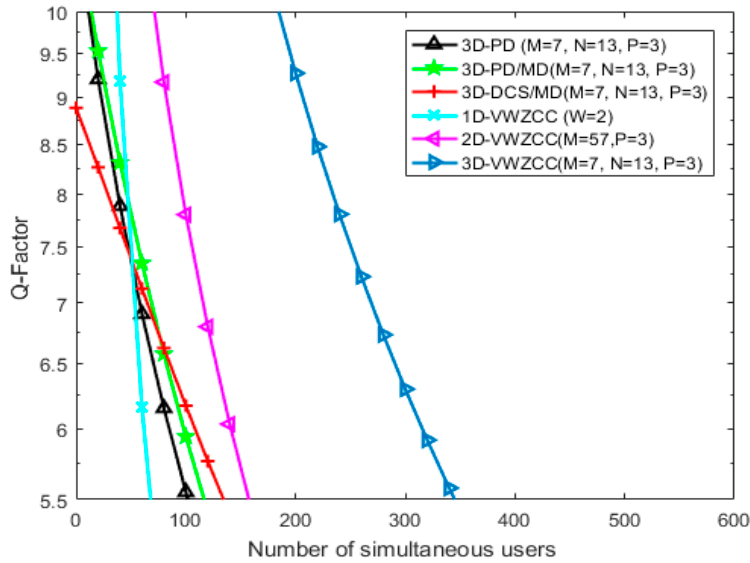
Figure 12. Q factor versus number of simultaneous users when effective source power P sr = − 10 dBm and data rate R b = 1.25 Gbps.